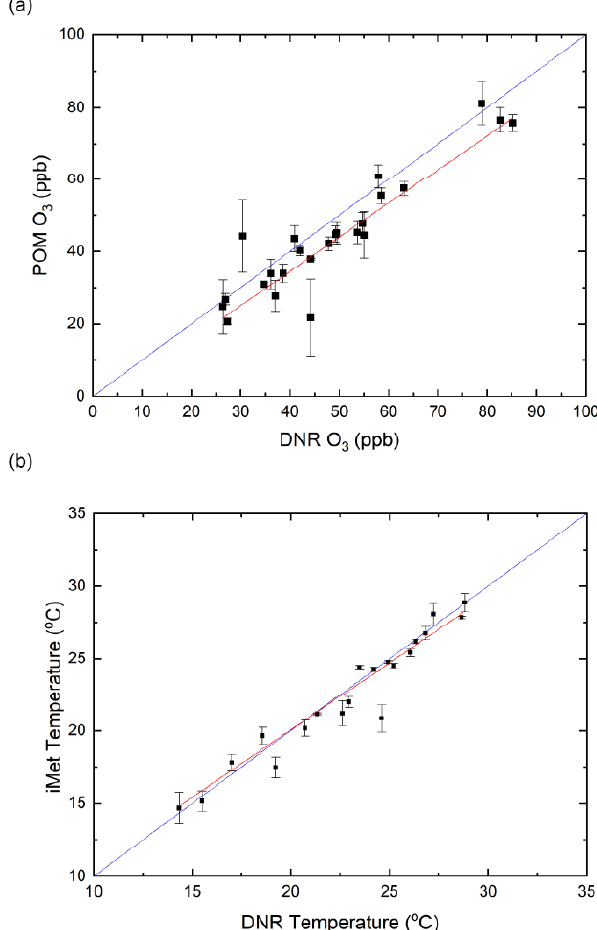
Figure 10. Intercomparison between measurements from instru- mentation on the M210 at 5ma.g.l. and at the Wisconsin DNR ground station for (a) O 3 (ppb) observations and (b) tempera- ture ( ◦ C). Blue lines depict 1 : 1 agreement, and red lines de- pict the linear regression best fit with (a) O 3(POM) = 0 . 944 ( ± 0 . 044) O 3(DNR) − 3 . 3 ( ± 1 . 9), R 2 = 0 . 955 and (b) T iMET = 0 . 929 ( ± 0 . 038) T DNR + 1 . 48 ( ± 0 . 93), R 2 = 0 .